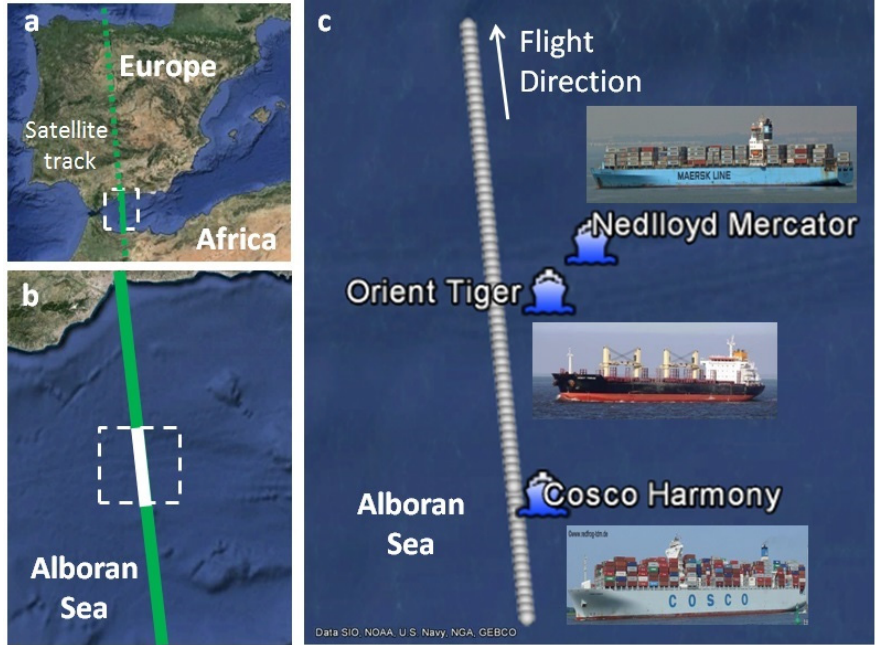
Figure 1. ( a ) Study area: the Alboran Sea between Europe and Africa in the Western Mediterranean Sea; ( b ) analyzed CryoSat-2 northward track segment; and ( c ) a zoom-in of the track segment with the position of the three ships used for the analysis.